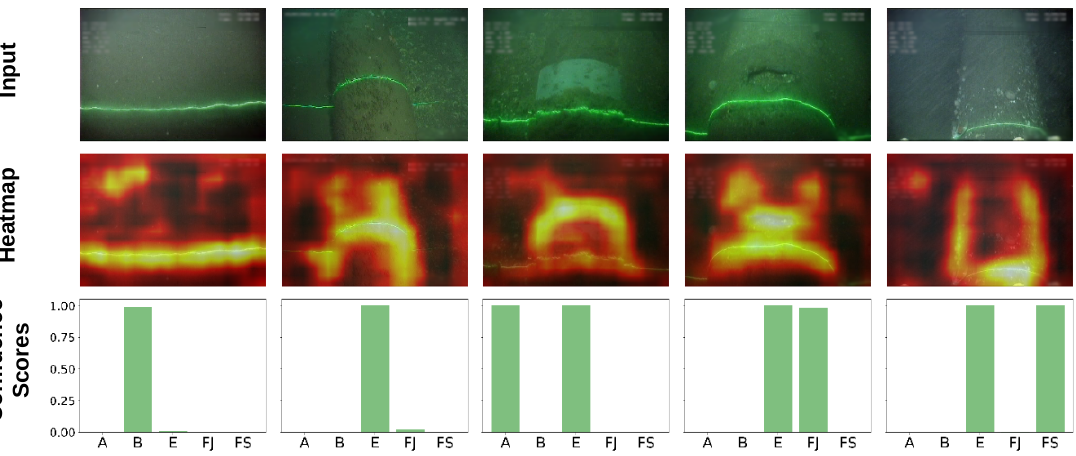
Figure 5. Ground truth label, image, heatmap and predicted confidence scores for the five different event